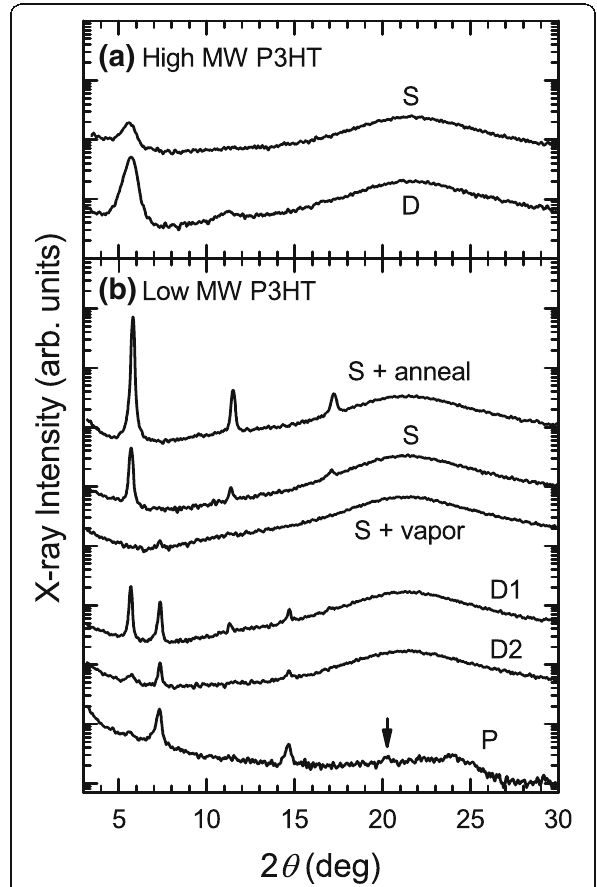
Fig. 1 Out-of-plane XRD patterns of a high and b low MW P3HTs. The arrow indicates the small reflection around 20.2°. S , D , and P mean the samples prepared by spin-coating, drop-casting, and precipitation, respectively. For more details of fabrication methods see the text. The extremely broad peak centered on 22° is a halo of quartz substrates. The patterns are vertically offset for